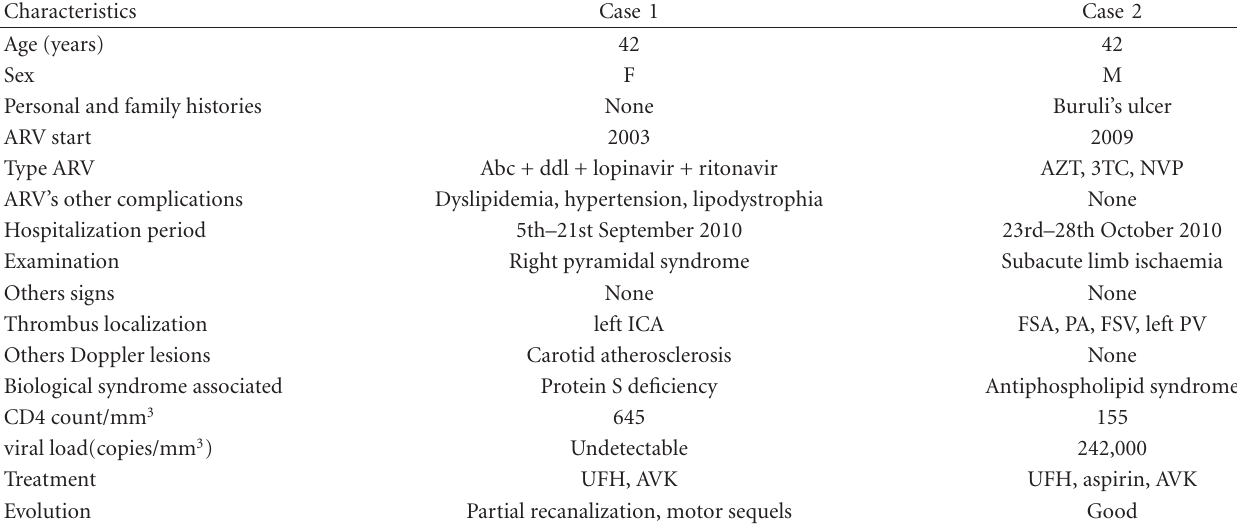
Table 1: Summary of the two